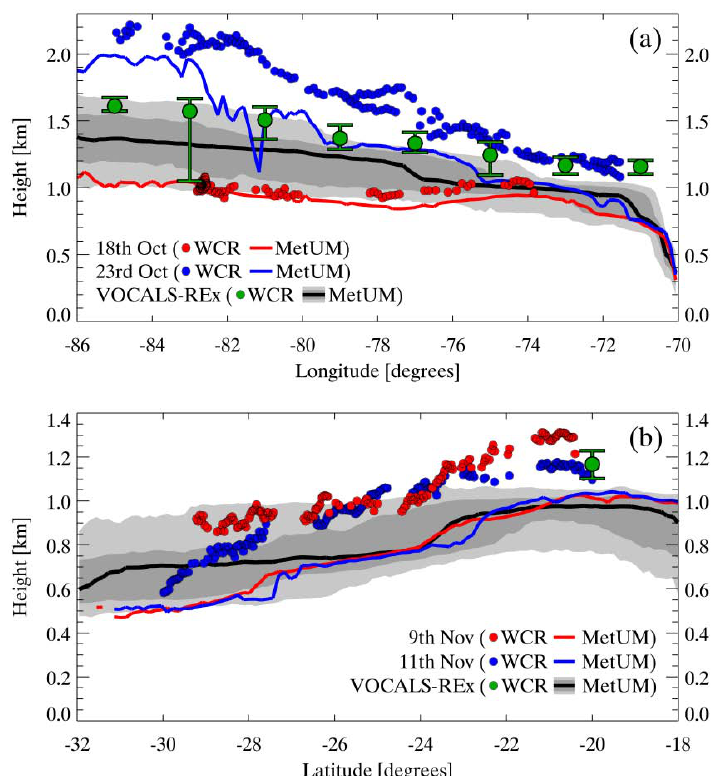
Fig. 3. Comparison of the measured and modelled cloud top height. The dark and lighter grey areas span the interquartile range and upper and lower deciles of the MetUM forecast data for the 14 October to 19 November 2008. The median of the MetUM data is shown with a solid black line. The green symbols and error bars show the median and interquartile range from all Wyoming cloud radar measurements made during the VOCALS-REx experiment. Panel (a) shows the variability along the 20 ◦ S latitude line. Observations and average daily MetUM data from the 18 and 23 October are highlighted in red and blue. Panel (b) shows the variability along the 73 ◦ W longitude line. Observations and average daily MetUM data from the 9 and 11 November are highlighted in red and